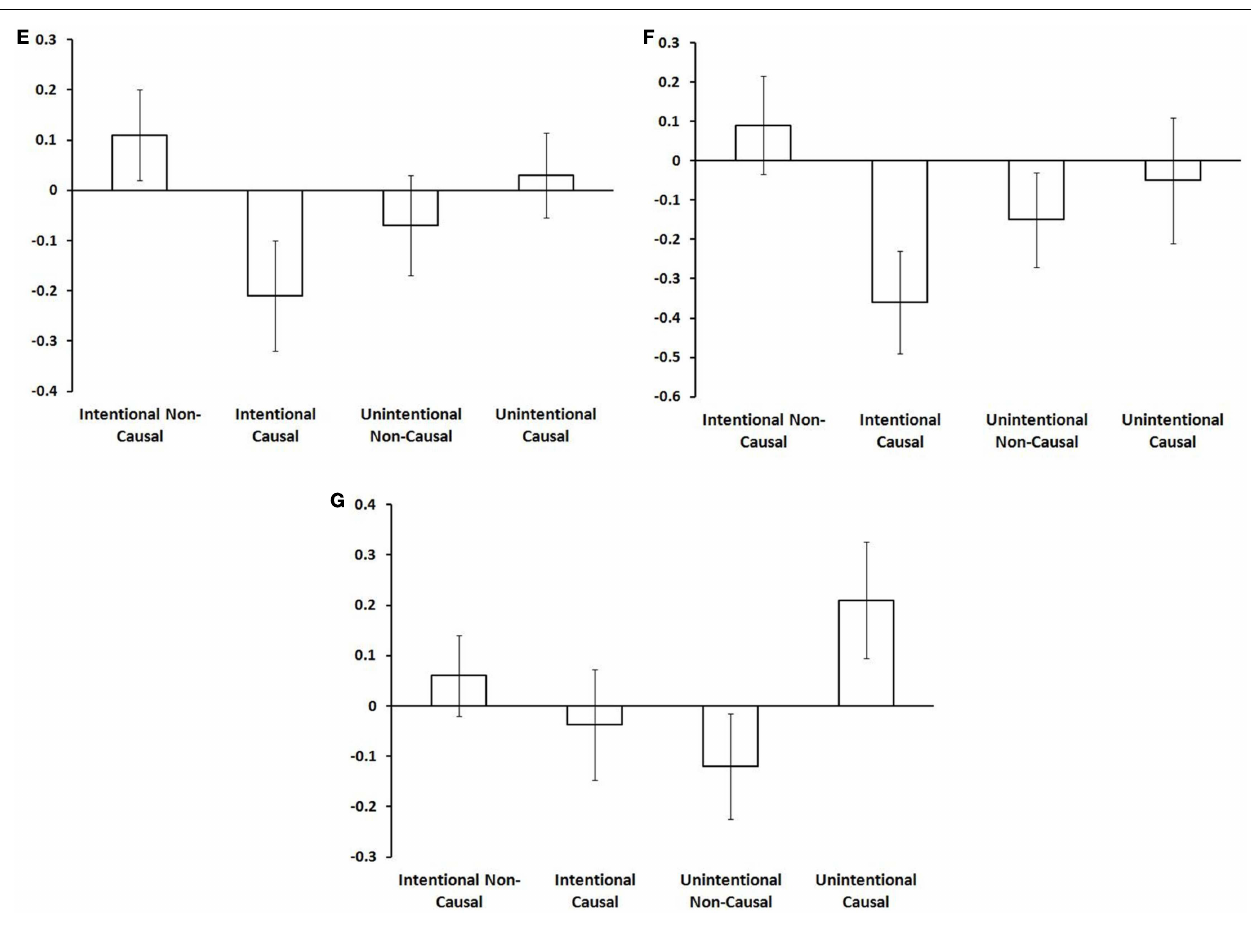
left mid-insula (A) . An increase in activation for intentional non-causal vs. intentional causal is found in right superior parietal (B) , right motor cortex (C) , right anterior insula (D) , left motor cortex (E) , and left superior parietal cortex (F) .The only area showing an increase in activation for unintentional causal vs. unintentional non-causal is left posterior insula (G)